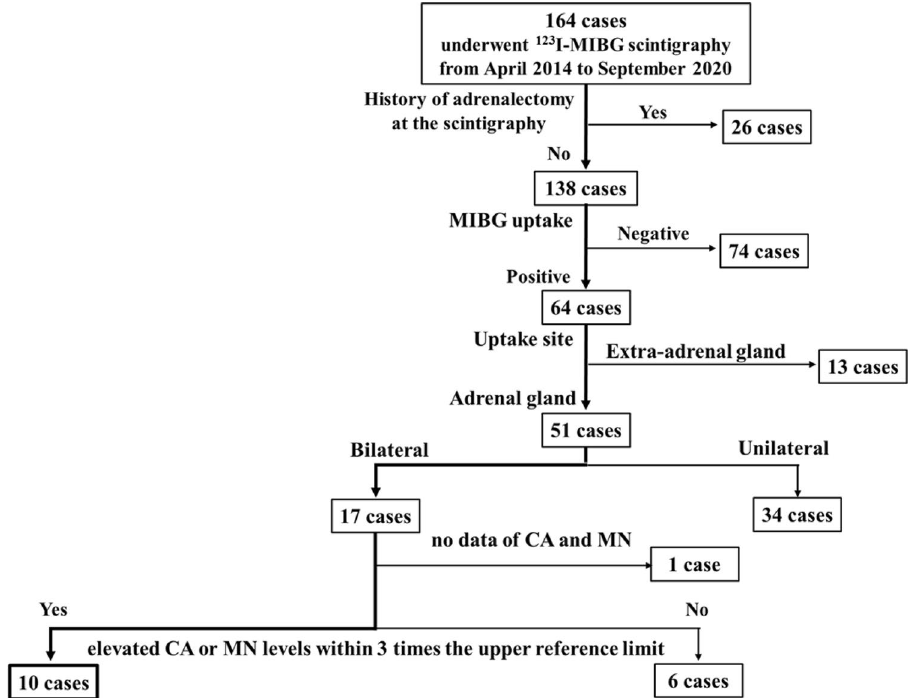
Figure 4. Catecholamine (CA); plasma adrenaline (Ad) and noradrenaline (NA) levels, metanephline (MN); urinary fractionated MN and normetanephrine (NMN).